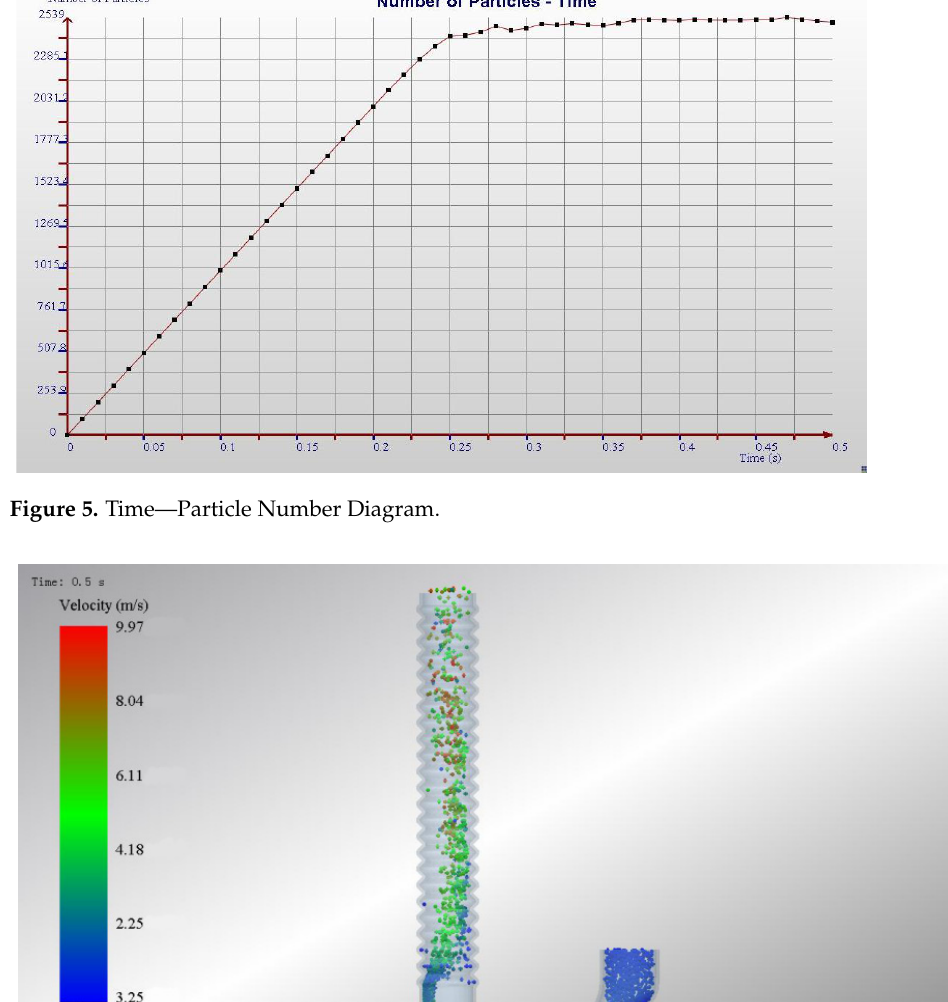
Figure 6. Particle velocity profile